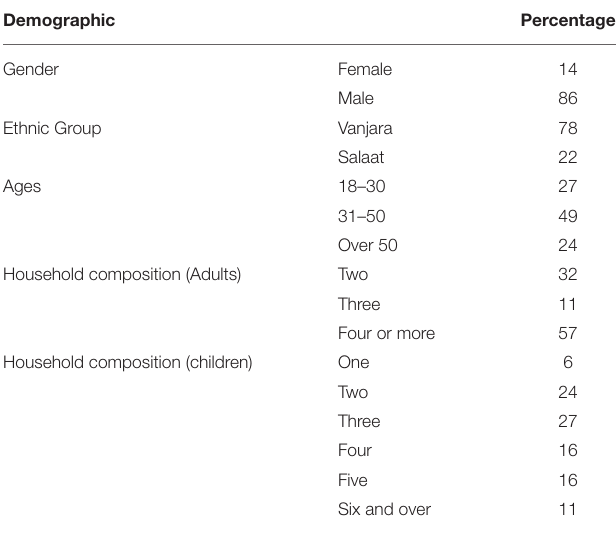
TABLE 1 | Demographic information of donkey owners in the